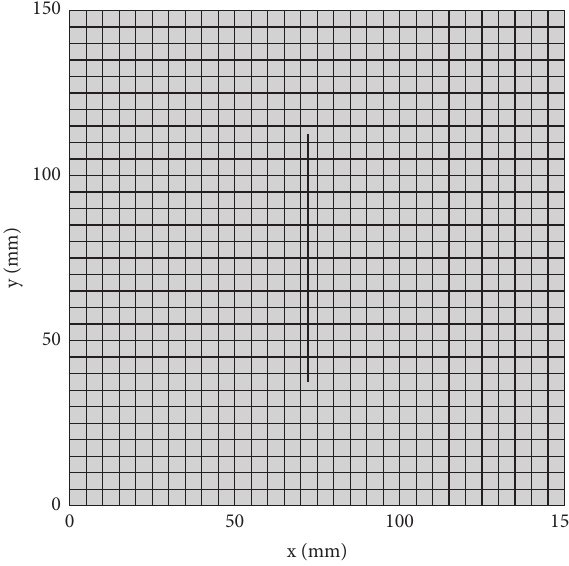
Figure 9: Mesh of the reservoir with one fracture.